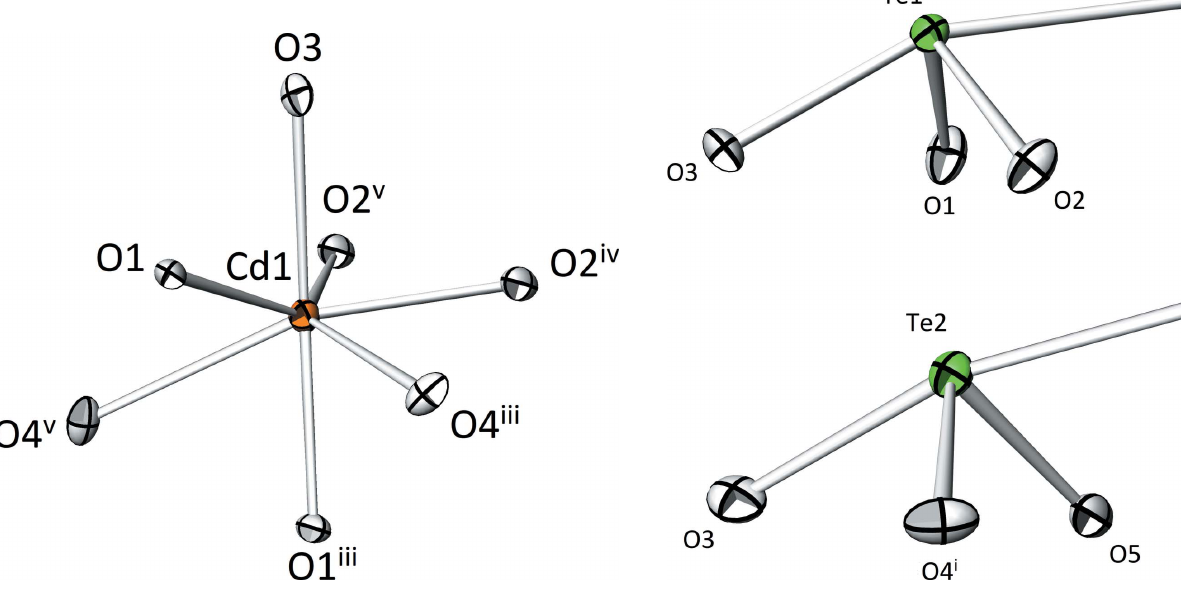
Figure 1 The [CdO 7 ] polyhedron in the crystal structure of (cid:2) -CdTe 2 O 5 . Displace- ment ellipsoids are drawn at the 90% probability level. Symmetry codes refer to Table